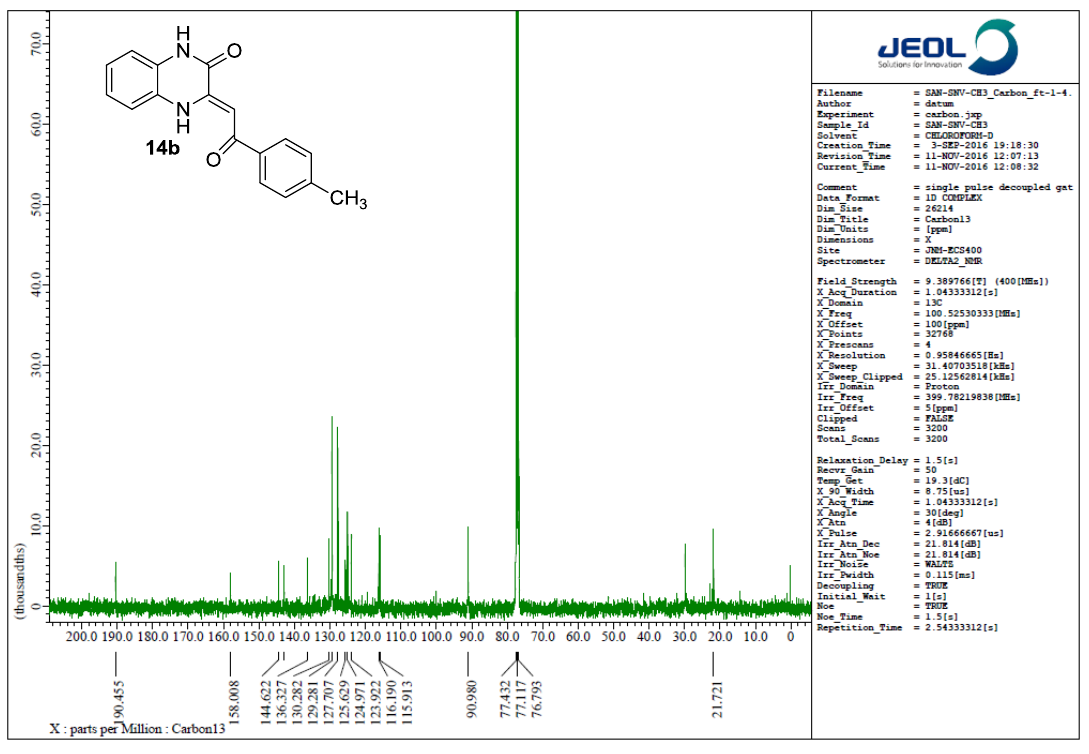
Figure 31 . 1 H NMR Spectra of Compound 14b .